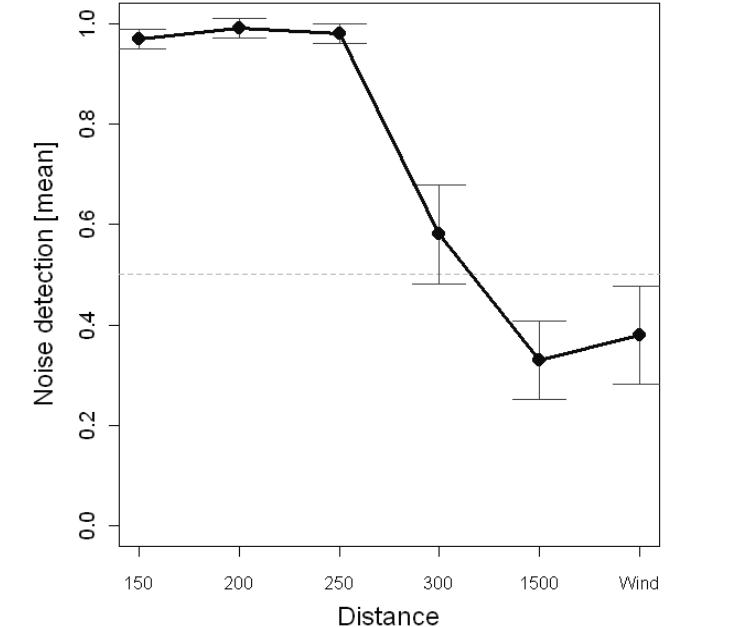
Figure 3. Noise detection ratings as a function of distance.